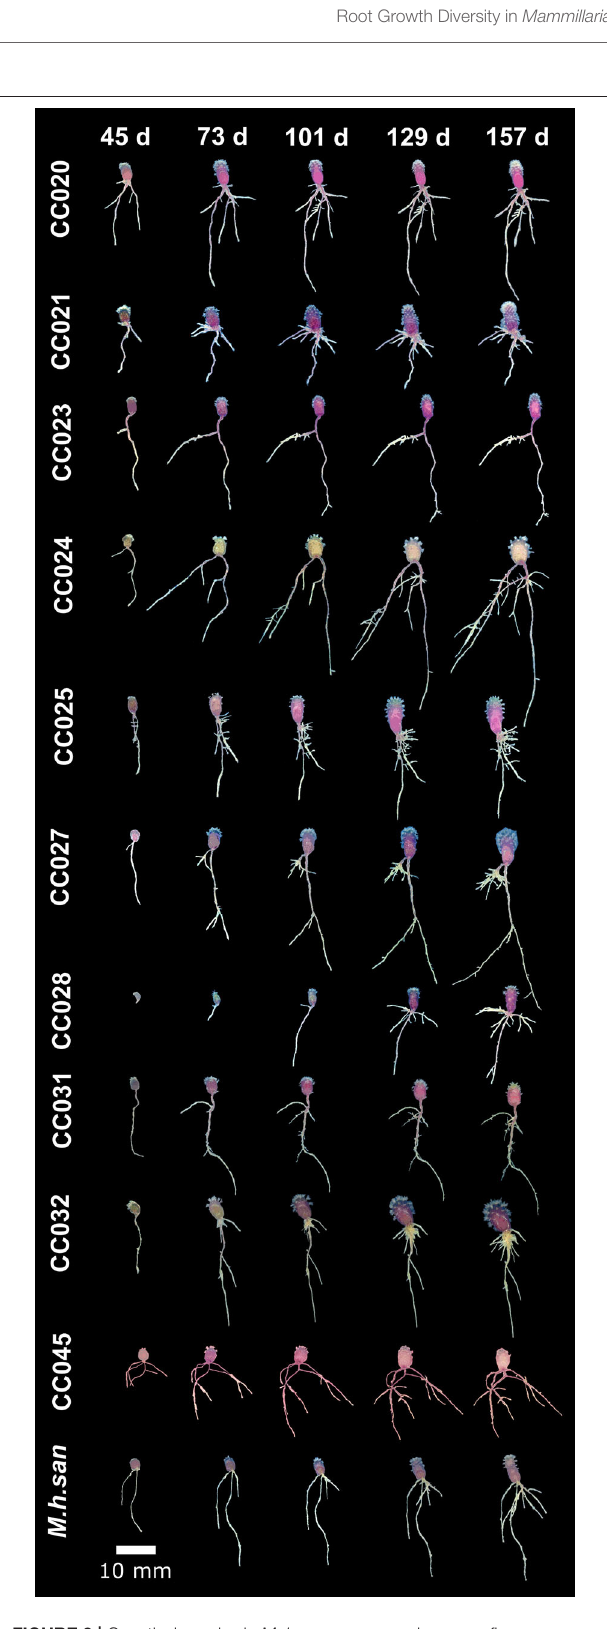
FIGURE 2 | Growth dynamics in M. haageana accessions over five developmental stages (45, 73, 101, 129, and 157 days after